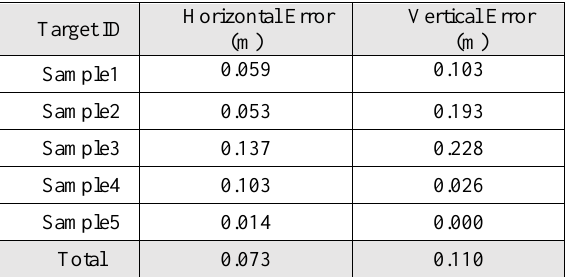
Table 3. Position difference of the same target in